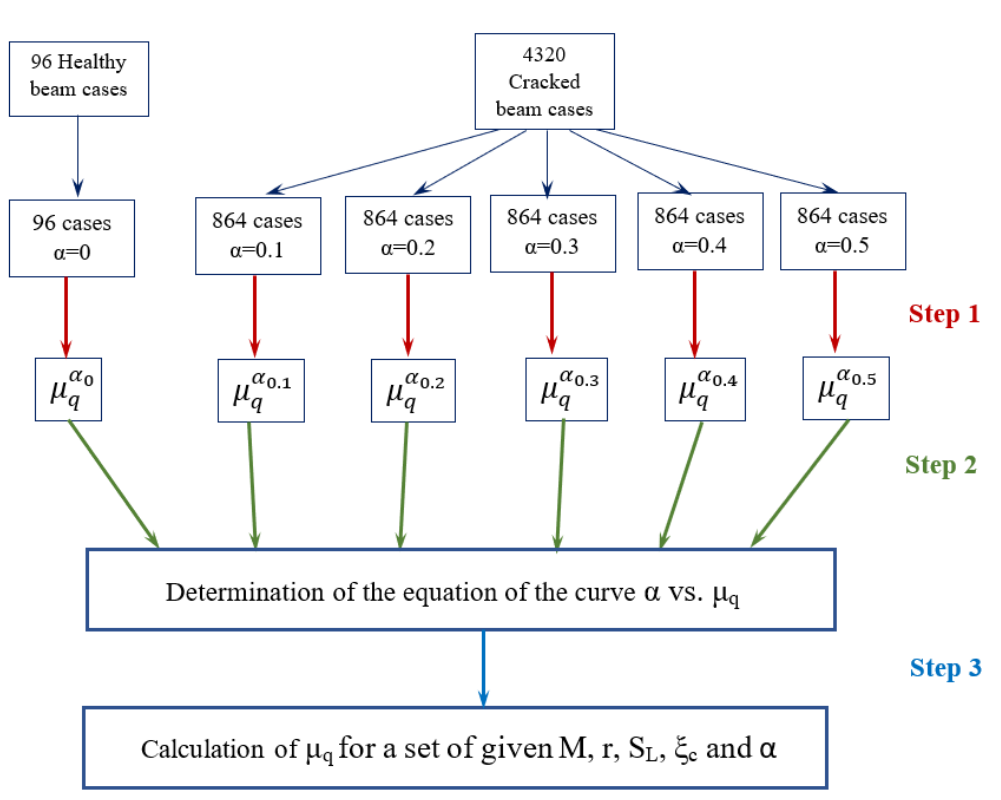
Figure 10. Scheme of the whole procedure to calculate the two closed-form solutions of non- dimensional natural